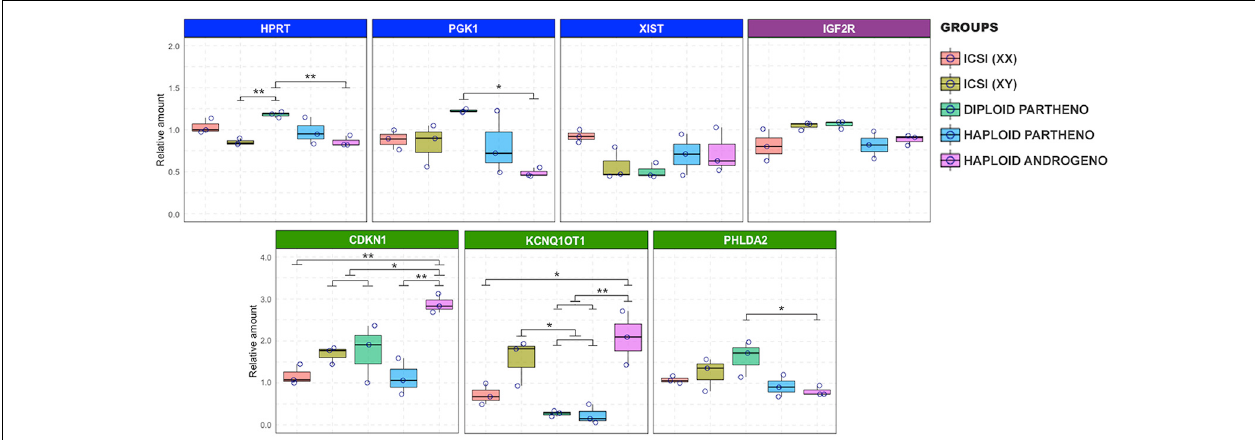
FIGURE 7 | Relative transcript levels of different imprinted and X chromosome-linked genes on haploid and diploid 8-cell stage embryos obtained by ICSI, parthenogenetic activation or ICSI + enucleation. Blue boxes: X chromosome-linked genes: XIST, PGK1, and HPRT; green boxes: genes on the KNCQ1 locus: KCNQ1OT1, CDKN1, and PHLDA2. GAPDH, ACTB, and SF3A were used as housekeeping genes for normalizations. ∗ p < 0.05, ∗∗ p <